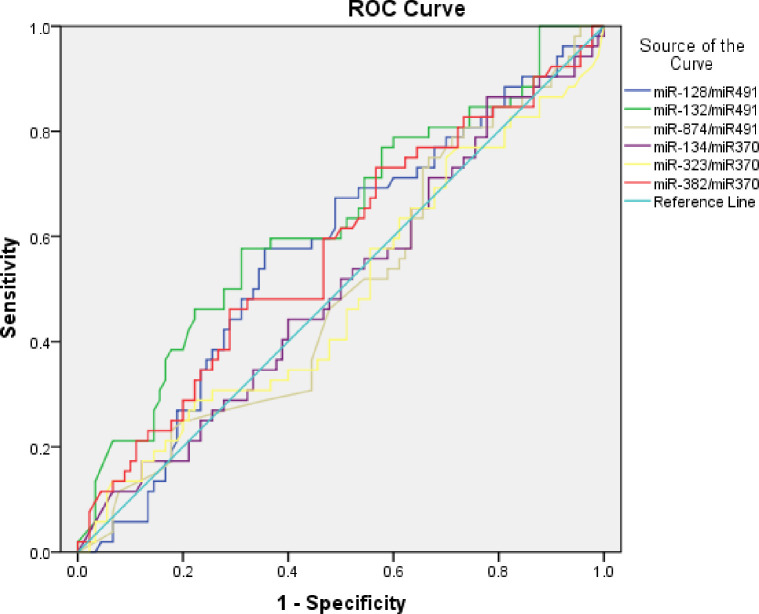
Receiver-Operating Characteristic (ROC) curve of miR128, miR132, miR874, miR134, miR323, miR382 to evaluate their diagnostic value for MCI among T2DM patients.